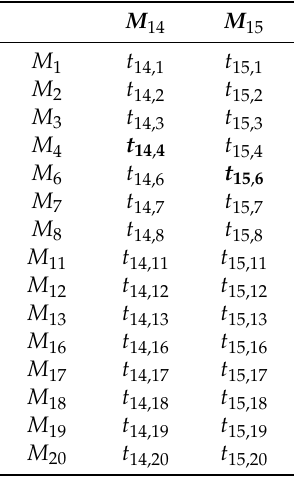
Table 3. Simplified GCAM (SGCAM) of Example